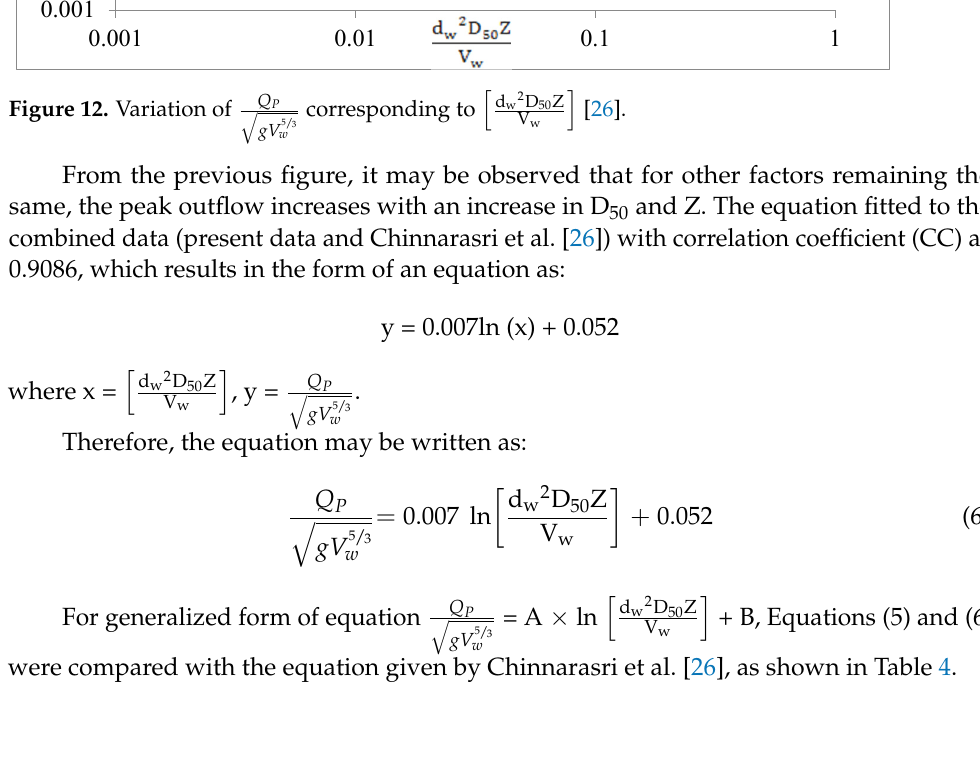
(cid:104) d w2 D 50 Z V